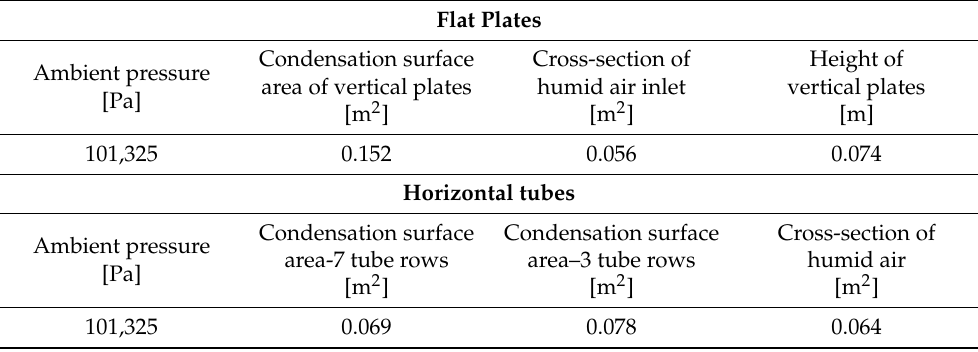
Figure 10. Comparison between the experimental, model-based theoretical values based on models M1–M5 and the model-based corrected (M1,corr) calculated values of the condensation mass fluxes. Table 5. Additional input data used for the calculation of the condensation mass